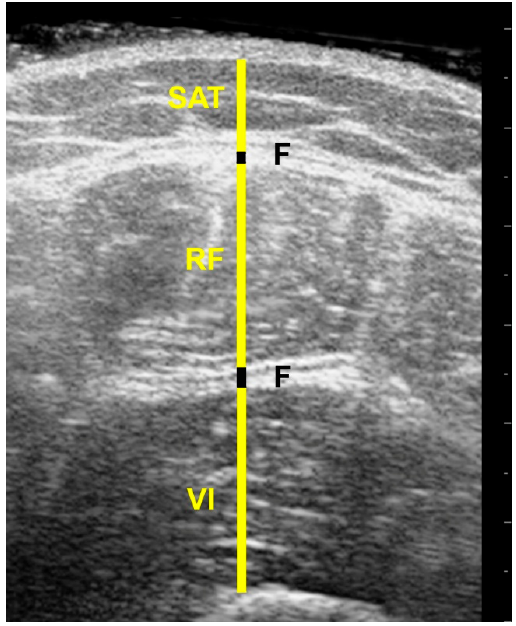
Figure 3. Ultrasound image of the anterior thigh; SAT = subcutaneous adipose tissue, F = Fascia, RF = Rectus Femoris muscle, VI = Vastus Intermedius muscle.